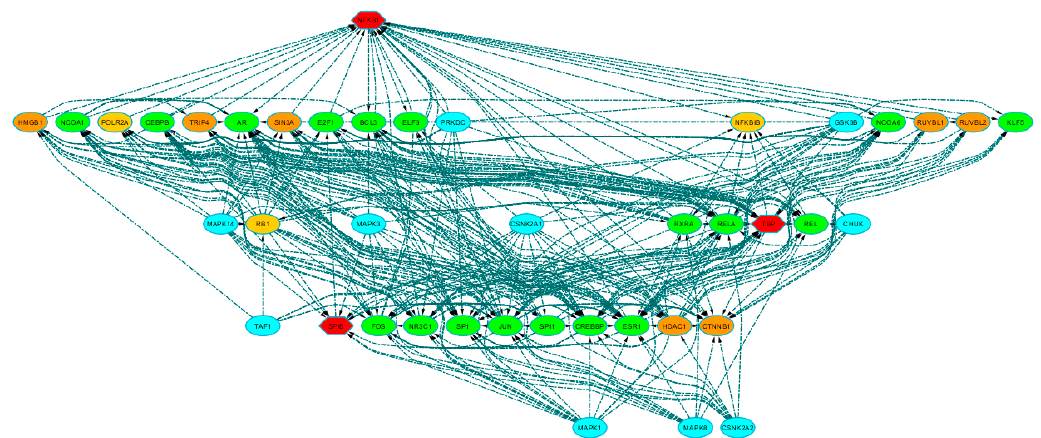
Figure 3. Extended regulatory network. The network shows the relationships (directed dashed edges) among the hub transcriptional factors, the additional proteins inferred by protein–protein interactions, and the most significant kinases identified by kinase enrichment analysis. Node shapes distinguish hub TFs (hexagon) from all the other inferred proteins (ovals). Node colors reflect node types or functions: hub TFs = red; inferred TFs = green; kinases = light blue; TcoFs = orange; inferred molecules with other functions = light orange. Also see Data Supplement 1d for detailed annotation.